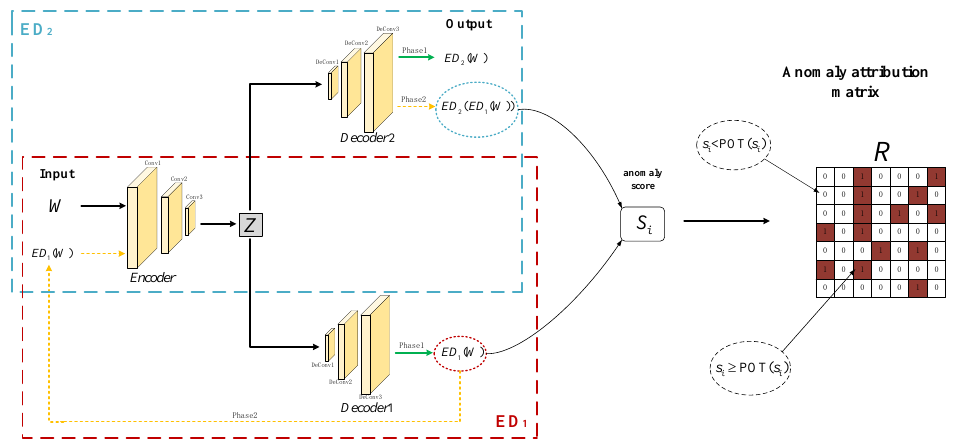
Figure 1. The overall architecture of